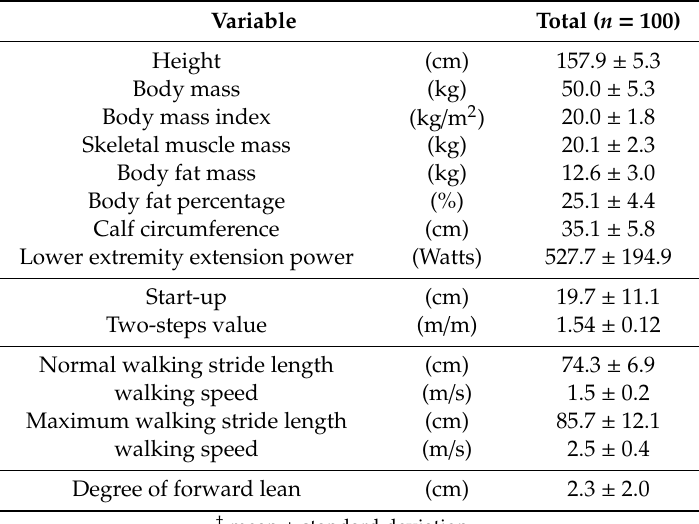
Table 1. Physical measurements †